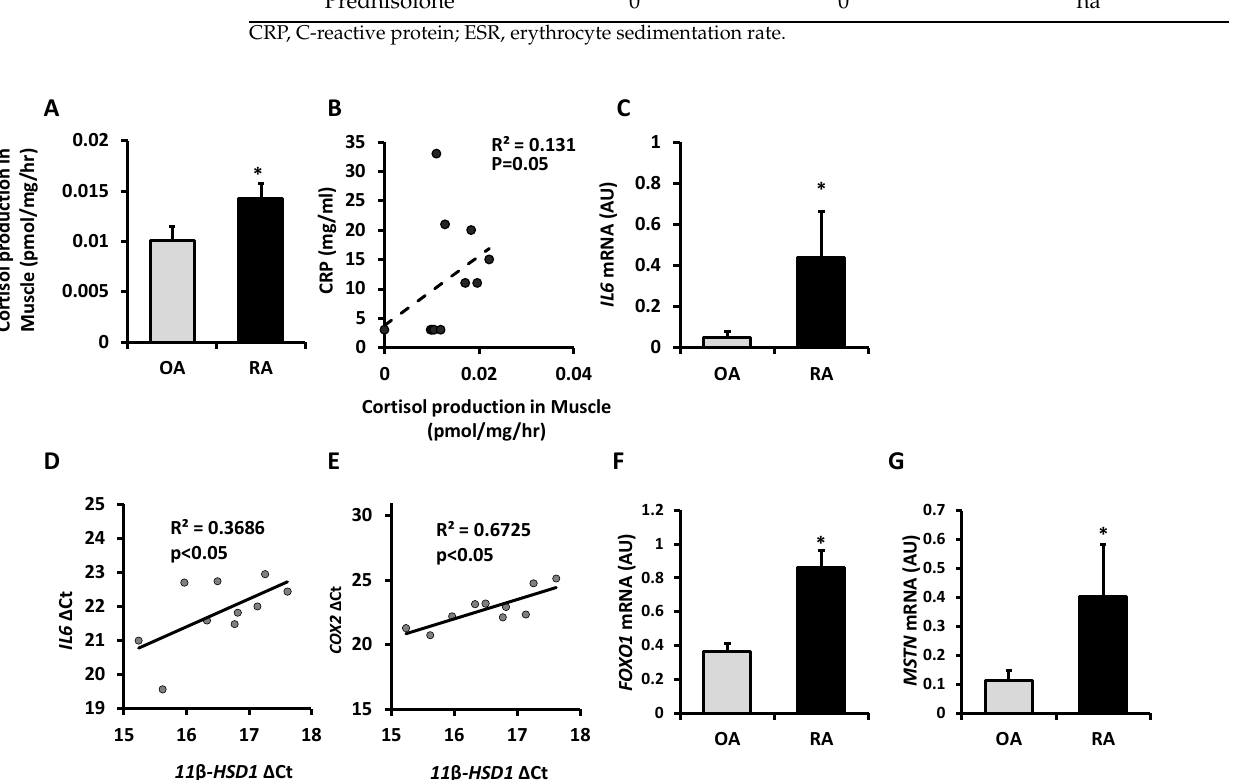
Figure 1. ( A ) Glucocorticoid activation by 11 β -HSD1 in ex vivo muscle explants freshly isolated after joint replacement surgery from patients with rheumatoid arthritis (RA, n = 10) and osteoarthritis (OA n = 12) determined by scanning thin- layer chromatography. ( B ) A significant correlation was seen between glucocorticoid activation (oxoreductase activity) and the serum C-reactive protein (CRP) measured before surgery in RA patients. ( C ) Gene expression (AU) of IL6 determined by RT qPCR in muscle homogenates from RA (n = 6) and OA (n = 4) patients. ( D ) Correlation between gene expression ( ∆ Ct) of 11 β -HSD1 with IL6 and ( E ) COX2 determined by RT qPCR in muscle homogenates from RA (n = 6) and OA (n = 4) patients. ( F ) Gene expression (AU) of FOXO1 and ( G ) MSTN determined by RT qPCR in muscle homogenates from RA (n = 5) and OA (n = 4) patients. Values are expressed as mean ± standard error. Statistical significance was determined using an unpaired t -test. * p <